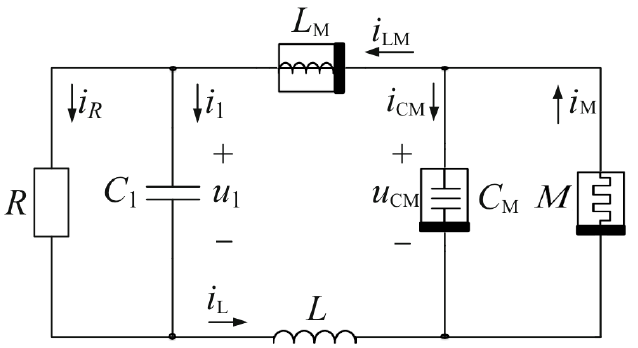
Figure 7. New oscillator circuit based on all known electrical